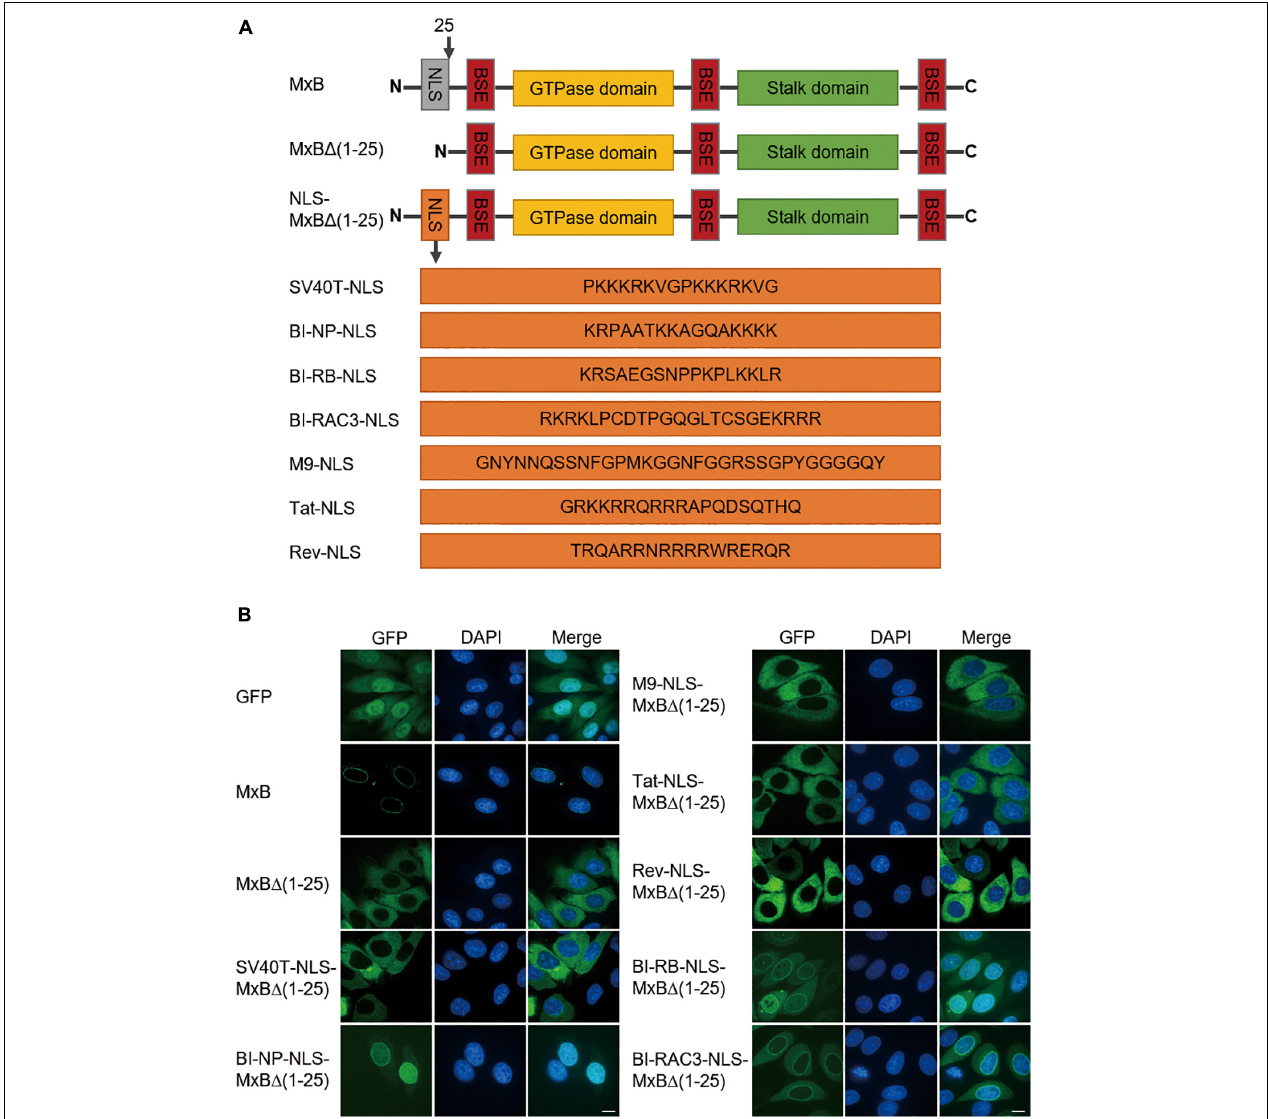
FIGURE 1 | The bipartite NLS supports MxB localization to the nuclear envelope. (A) Schematic representation of wild type full-length human MxB, N-terminal truncated MxB (cid:49) (1–25), and MxB variants with N-terminal 25 amino acids replaced by heterologous NLS. The amino acid sequences of NLS are shown. NLS, nuclear localization signal. BSE, bundle signaling element. (B) HeLa cells were transfected with either wild type MxB or MxB mutants bearing a C-terminal GFP tag. The subcellular localization of MxB and its mutants was visualized by confocal laser scanning microscopy. Scale bars represent 10 µ